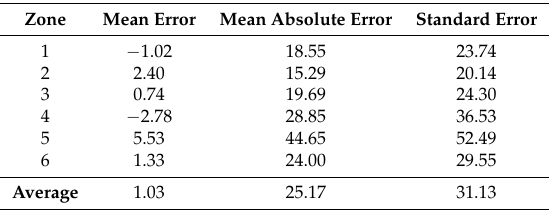
Table 4. Mean errors in the Paris instances.